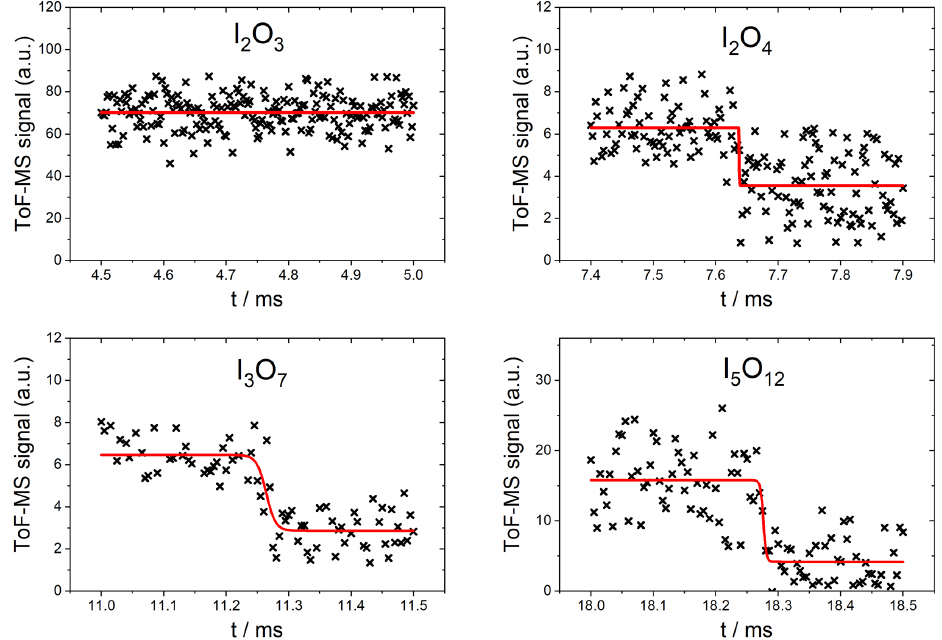
Figure 7. Measured photodepletion at 355nm of I 2 O 3 , I 2 O 4 , I 3 O 7 , and I 5 O 12 . The laser was triggered at 4.75ms in the I 2 O 3 experiment. The red line indicates the fit to Eq.